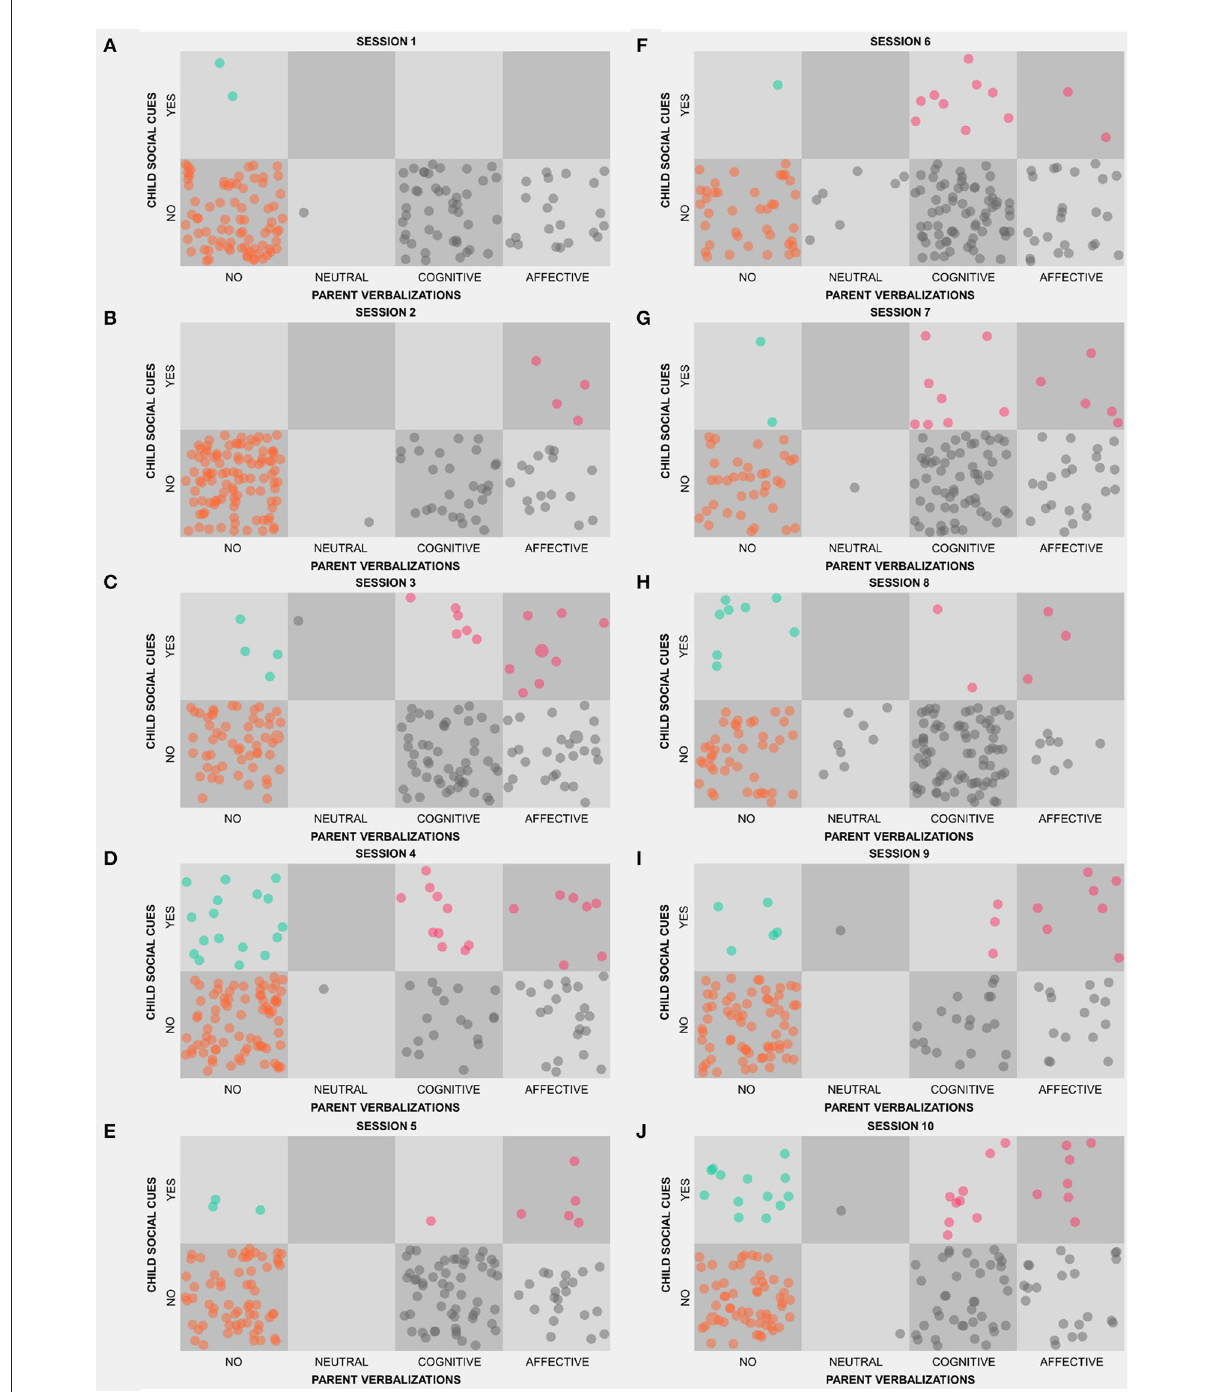
FIGURE3 State Space Grid (SSG) representations of the father-child dyadic interaction from session 1 (A) to session 10 (J) .